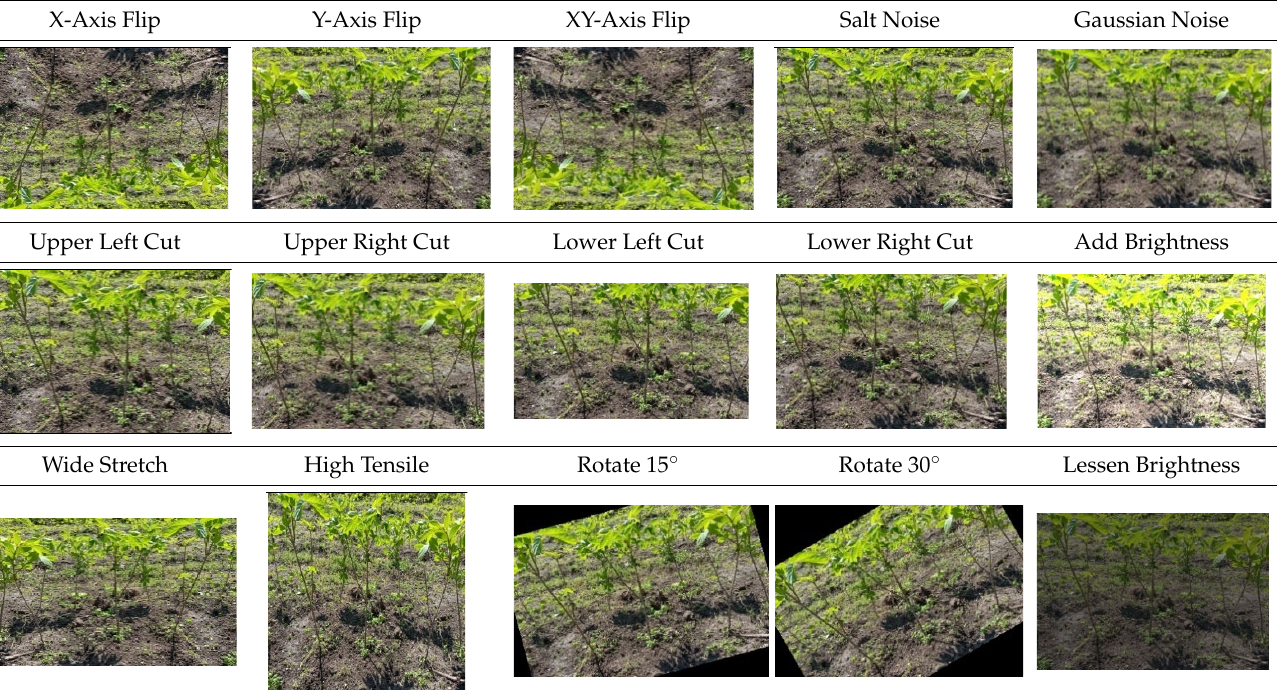
( e ) Figure 2. Images of five saplings: ( a ) large, ( b ) medium and ( c ) small spruce; ( d ) Manchurian ash; ( e ) Mongolian scotch pine. 2.2.2. Data Augmentation YOLOV4 [34] comes with data augmentation functions, such as Mosaic, which can enrich various objects and backgrounds, greatly improving YOLOV4 performance and effectively solving the problem of the poor detection of smaller volume objects in model training. However, for the YOLO series, obtaining a larger dataset for the training and validation of the network model results in training weights that better fit this type of data